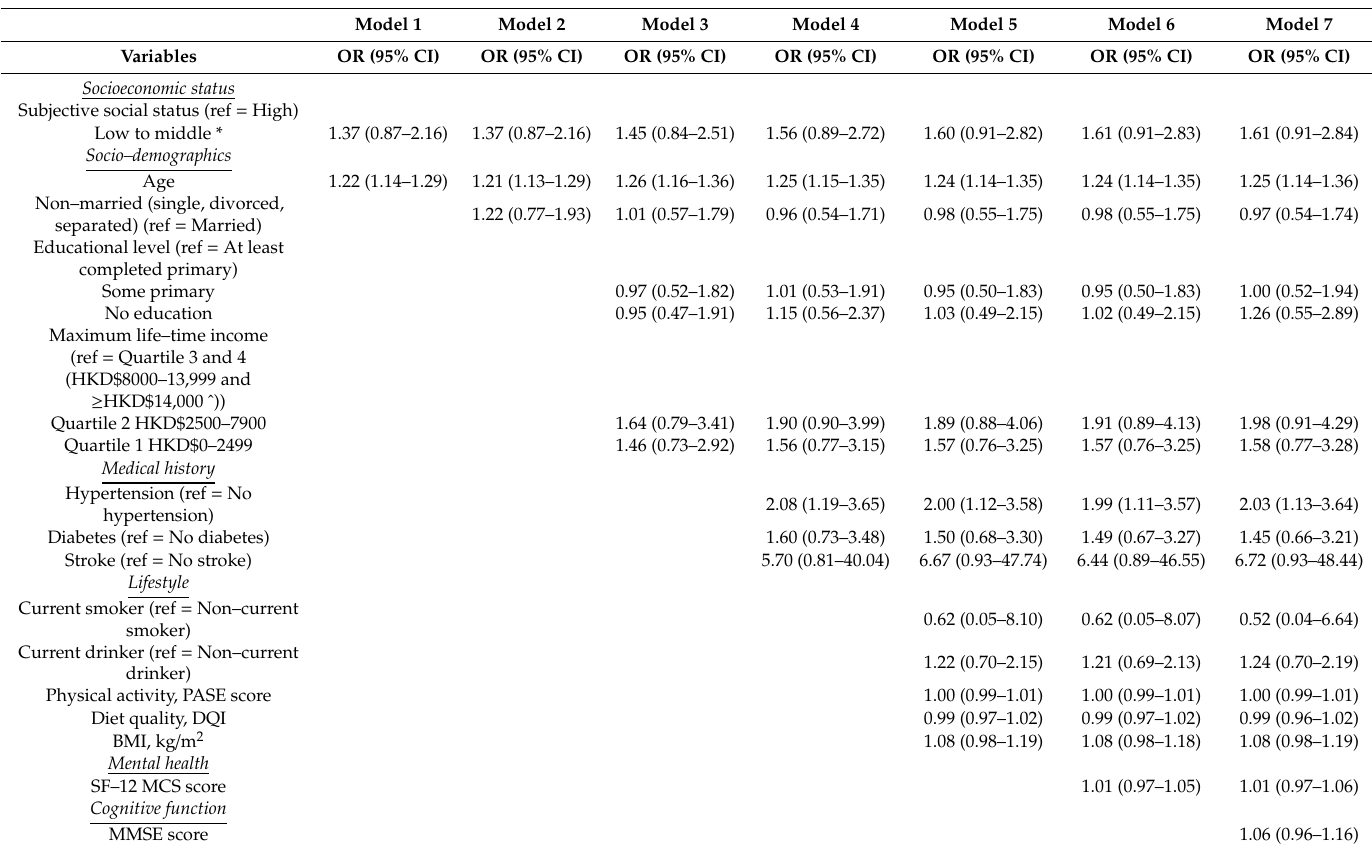
Table 5. Subjective social status (community status ladder) at baseline and the risk of incident frailty at 14-year follow-up, women (n =